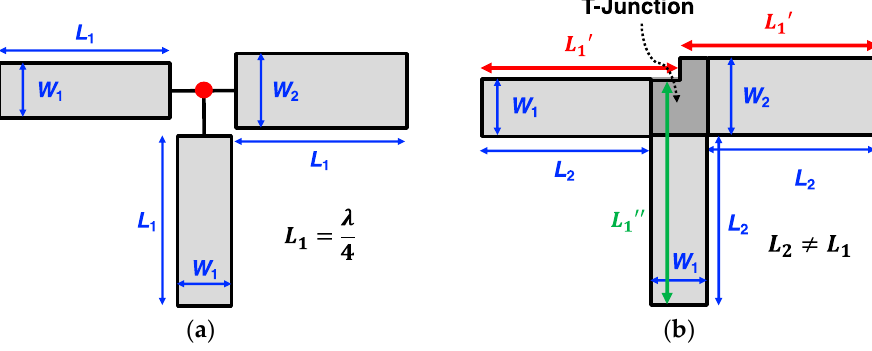
Figure 3. T-junction interconnection of the transmission lines in the conventional branch-line coupler: ( a ) theoretical description using a single point junction; ( b ) physical dimension in layout design for realization on a printed circuit board (PCB).